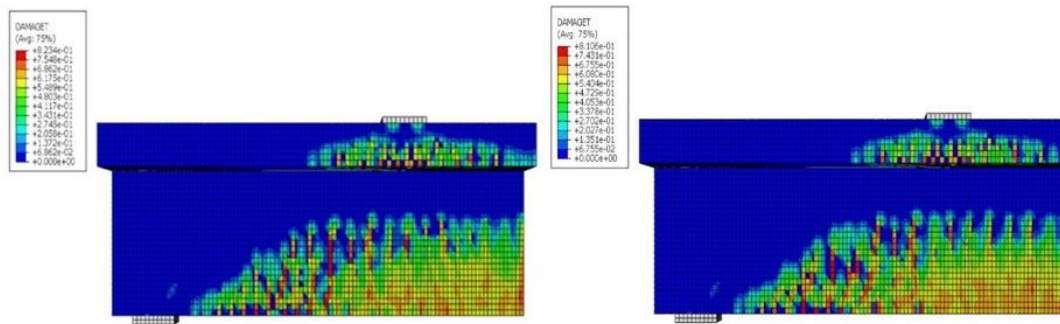
Figure 21: The numerical crack patterns of the specimens PB3 (left) and PB4 (right)